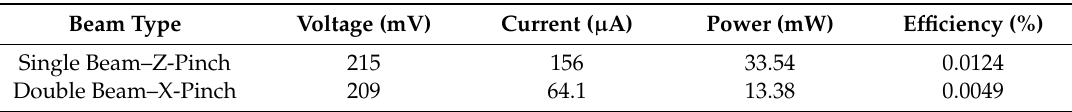
Table 3. The results of the power and efficiency for both the single and double beam